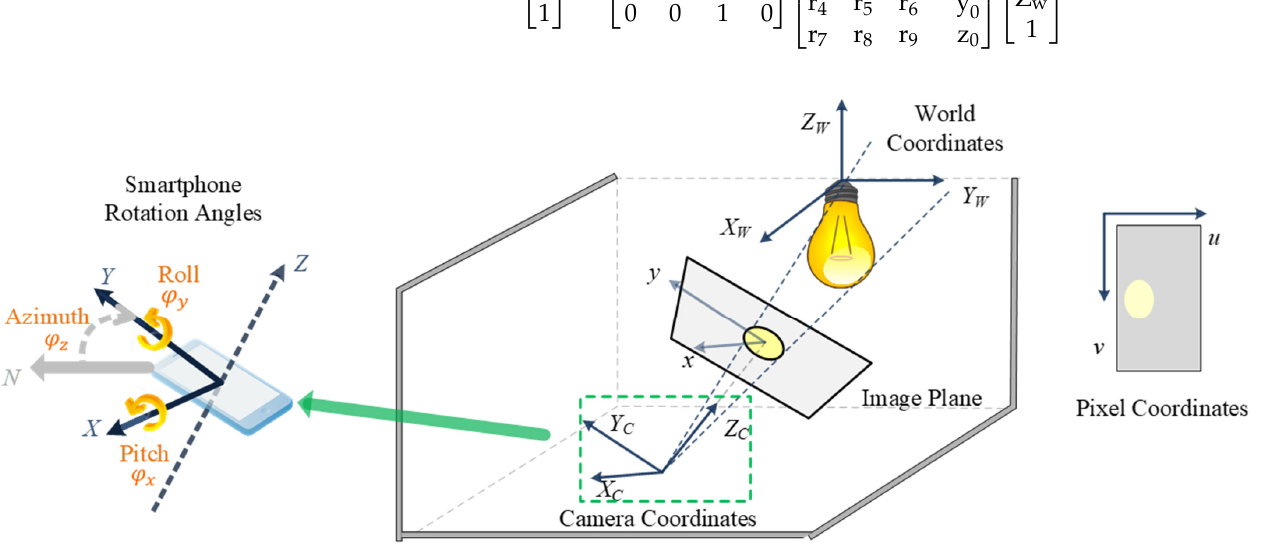
Figure 5. Imaging geometry of proposed direction angle data supported 3D positioning system [34].